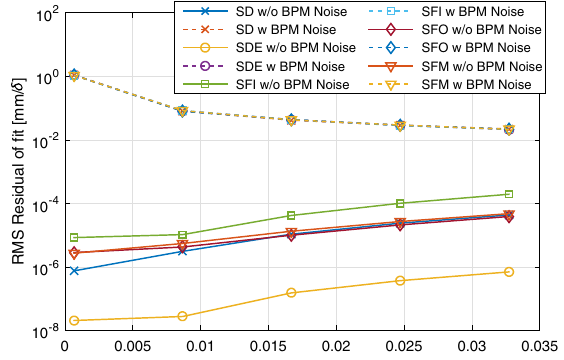
FIG. 4. RMS residuals of a linear fit to the OEOR dependence on a ∼ 10% sextupole change vs used energy-shift. The simulated BPM noise is normally distributed with σ ¼ 0 . 40 μ m. The nonlinear contribution of the BPM noise dominates, making it beneficial to choose as large an energy-shift as